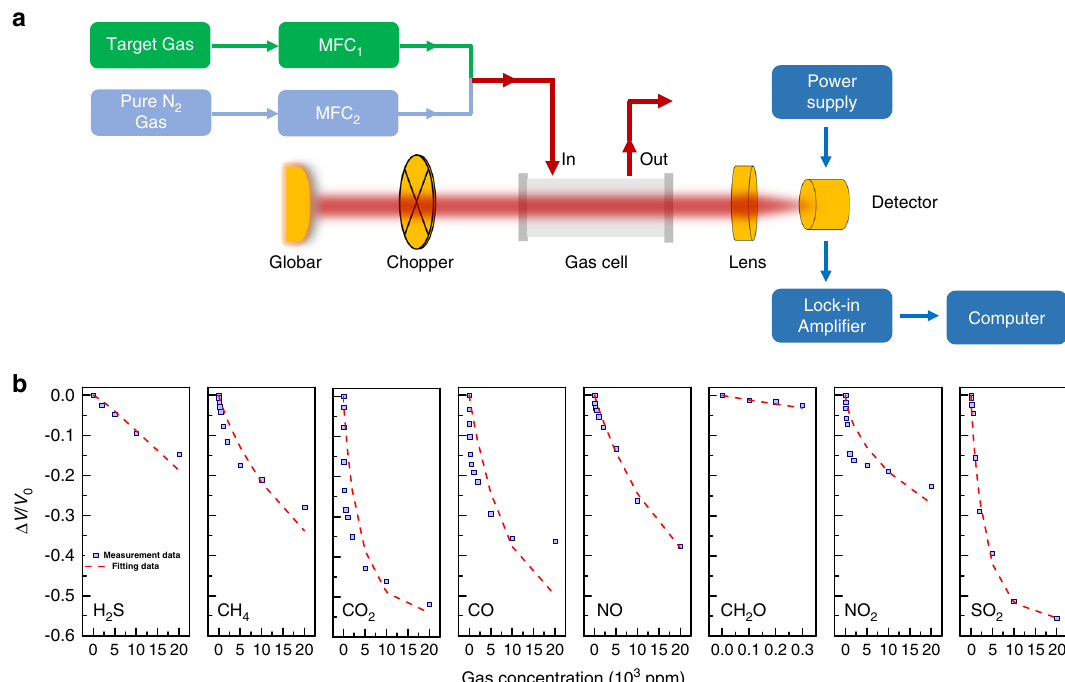
Fig. 5 The NDIR experiment on single-target gas using the narrowband pyroelectric detectors. a The gas sensing system. b The voltage responses of the narrowband detectors as a function of the concentrations of the target gases. The purple squares stand for the measured data while the red dashed lines are the fi tting curves based on the Beer – Lambert law. Source data are provided as a Source Data fi